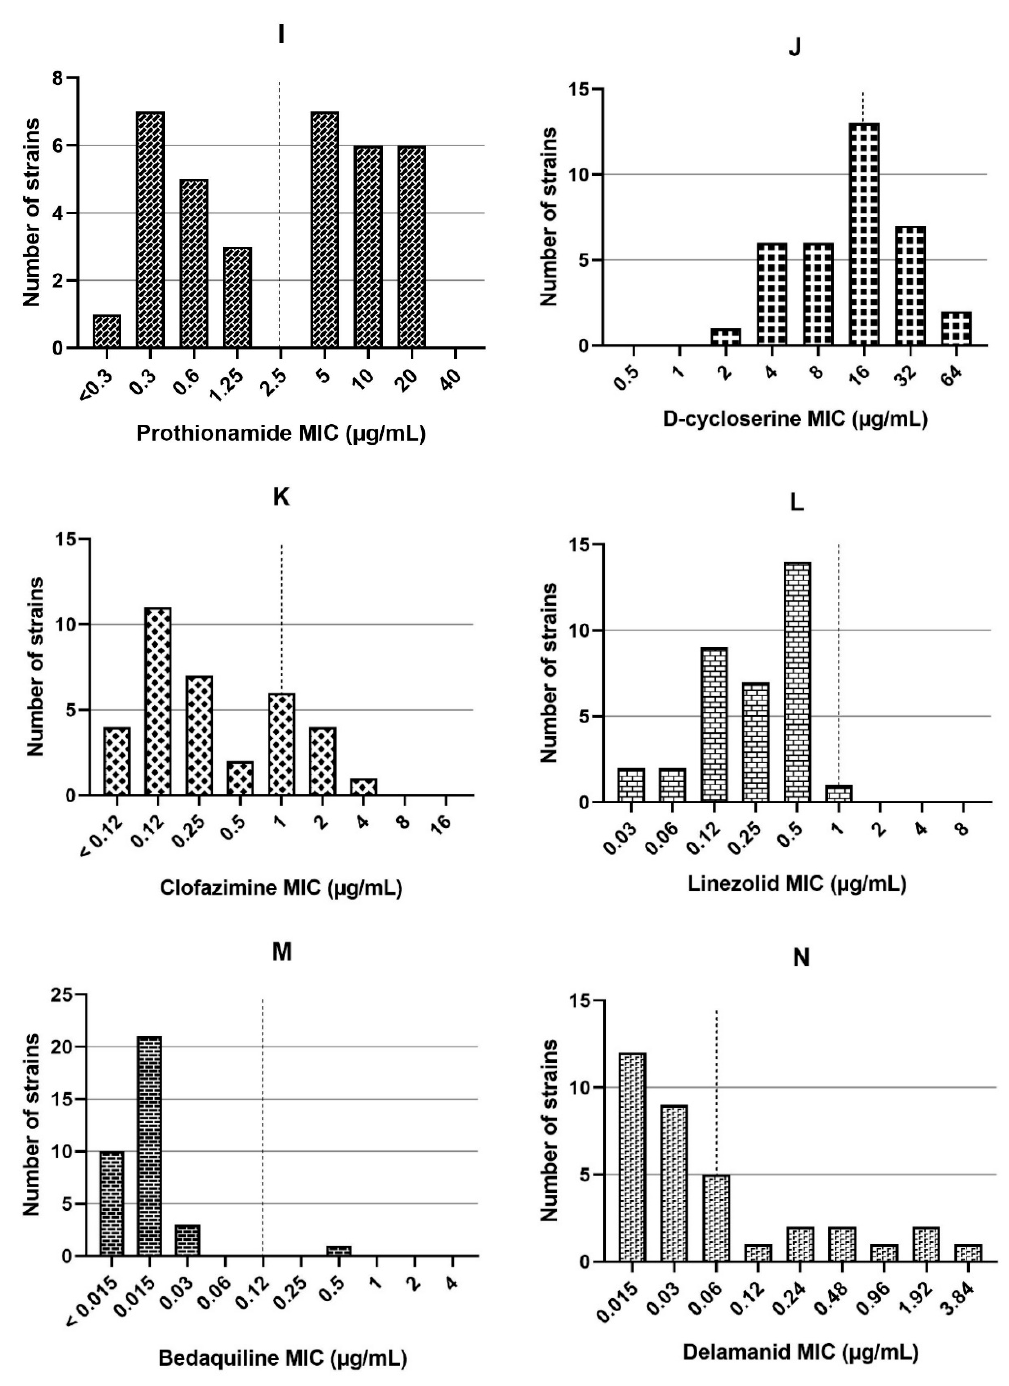
Figure 1. The minimum inhibitory concentrations (MICs) for rifampicin ( A ), isoniazid ( B ), and ethambutol ( C ), levofloxacin ( D ), moxifloxacin ( E ), amikacin ( F ), kanamycin ( G ), capreomycin ( H ), prothionamide ( I ), D-cycloserine ( J ), clofazimine ( K ), linezolid ( L ), bedaquiline ( M ), and delamanid ( N ) in 35 rifampicin-resistant Mycobacterium tuberculosis strains. The dash line indicates critical concentrations.